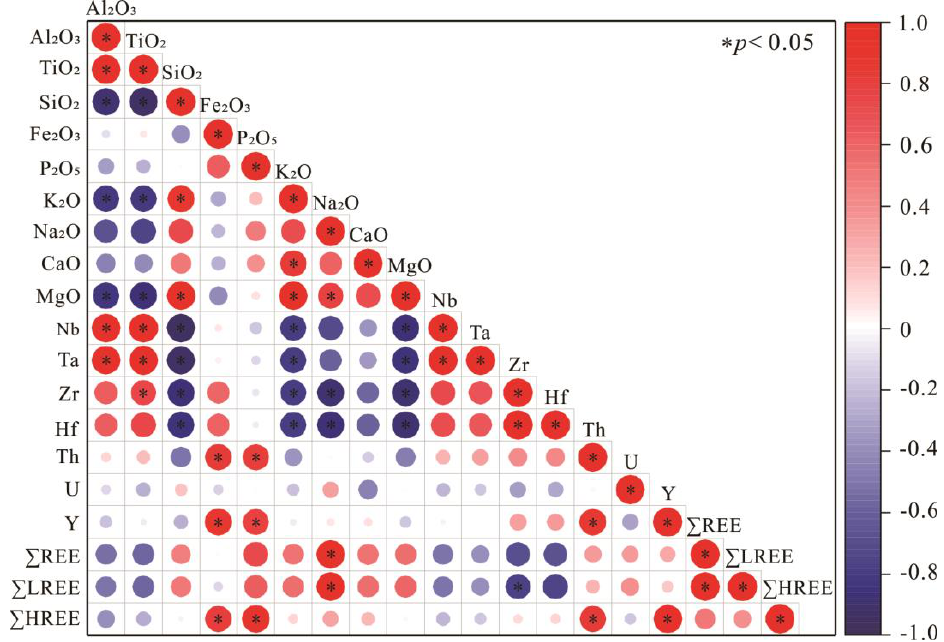
Figure 7. Correlation analyses (Pearson′s r) for selected major, trace, and rare earth elements in the Lindai bauxite deposit, central Guizhou Province (data from [28]).